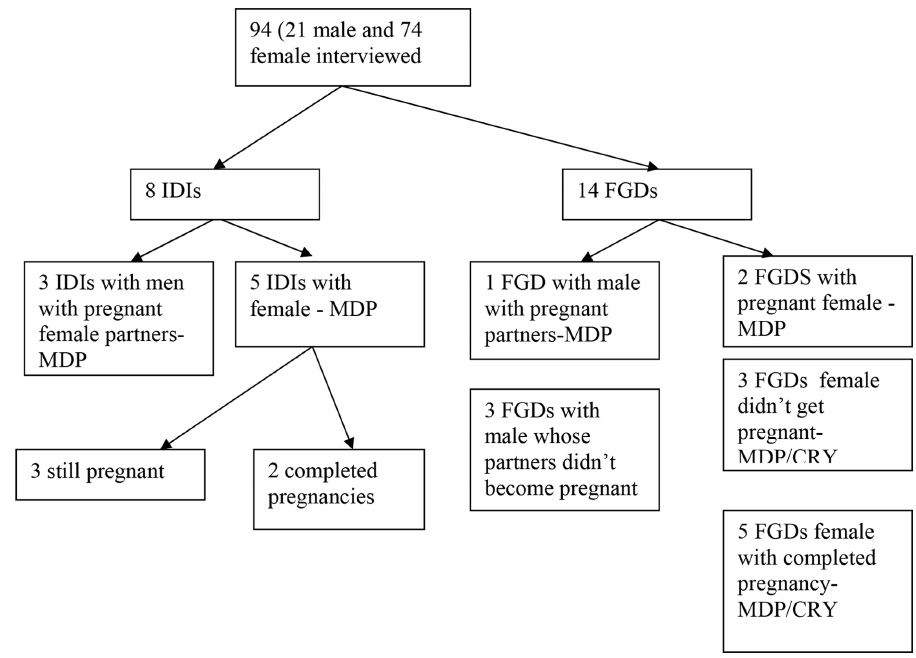
Figure 1. The distribution of participants in the study.